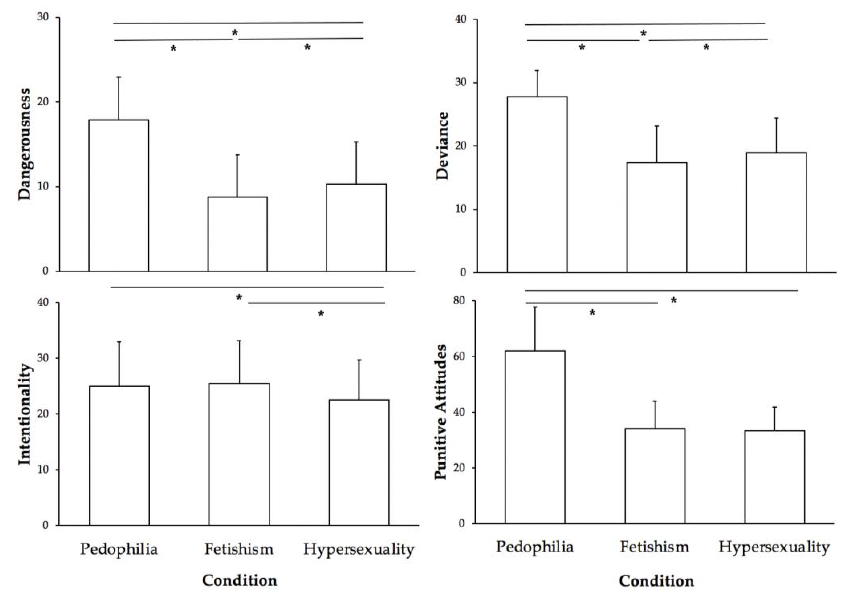
Figure 2. Dangerousness, Deviance, Intentionality, and Punitive Attitudes Scores for Pedophilia, Fetishism, and hypersexuality with Significance Indicators ( * ).